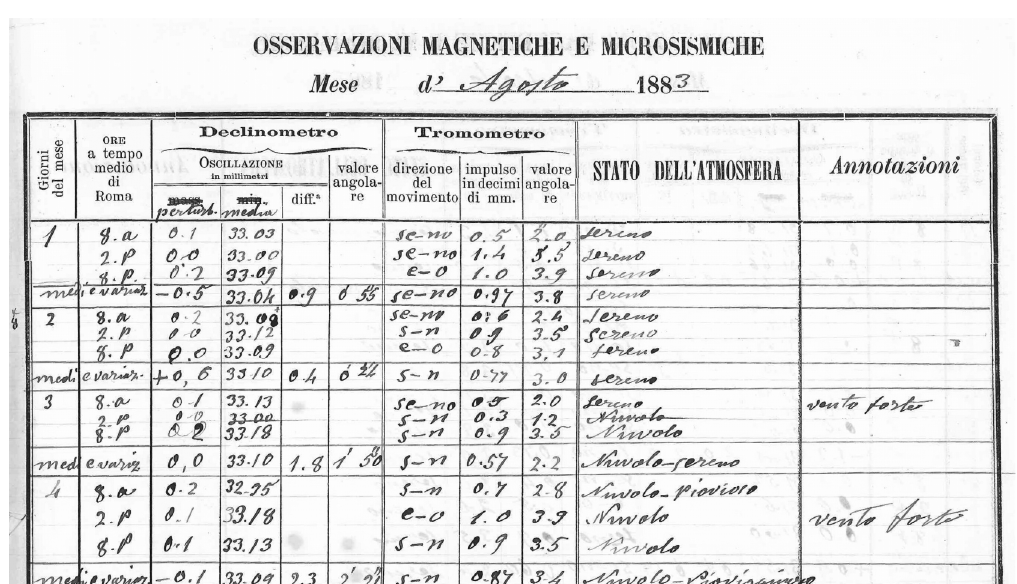
Fig. 3. Tromometric and geomagnetic observations from the register preserved at the Alberoni